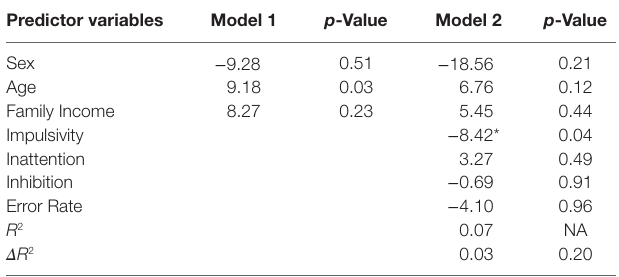
Table 4 | Sequential regression analysis of predictors of science scores.